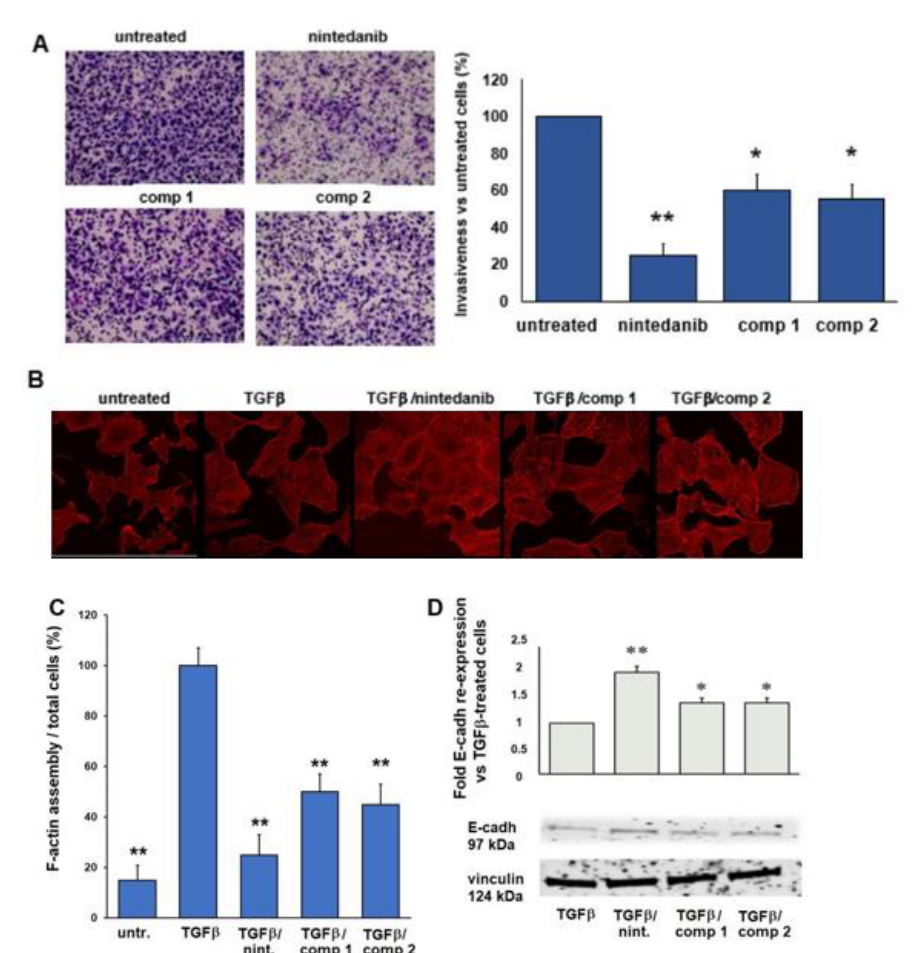
Figure 9. ( A ) Representative images of TGF β -treated A549 cells invasiveness after growth in the presence of compounds 1 , 2 , or nintedanib at 5 µ M for 24 h (left panel). Cells were allowed to migrate towards fibronectin-coated filters (10 µ g/ µ L). Right panel, quantification of invasiveness. Data are percentages of migrated cells compared to untreated cells and expressed as mean value ± SEM of at least three independent experiments. * p < 0.05 and ** p < 0.001 vs. untreated cells. ( B ) Representative images of fluorescence confocal analysis of TGF β -treated A549 cells exposed to nintedanib or compounds 1 and 2 at 5 µ M for 24 h. After incubation, cells were fixed and processed for fluorescence confocal imaging. The cell cytoskeleton was stained with rhodamine-conjugated phalloidin. Image dimensions: 180 × 180 µ m, scale bar 50 µ m. Experiments were performed at least three times. ( C ) Quantification of disassembled cytoskeleton expressed as the percentage of cells with point-like fluorescence signals/total cells per field. Data are representative of three independent experiments. * p < 0.05, and ** p < 0.001 vs. TGF β treated cells. ( D ) E-cadherin re-expression, in TGF β -treated A549 cells grown in the presence of nintedanib or compounds 1 and 2 at 5 µ M for 24 h. Left panel, representative Western blot of E-cadherin protein expression. Right panel, densitometric analysis of E-cadherin re-expression in percentages, * p < 0.05, and ** p < 0.001 vs untreated